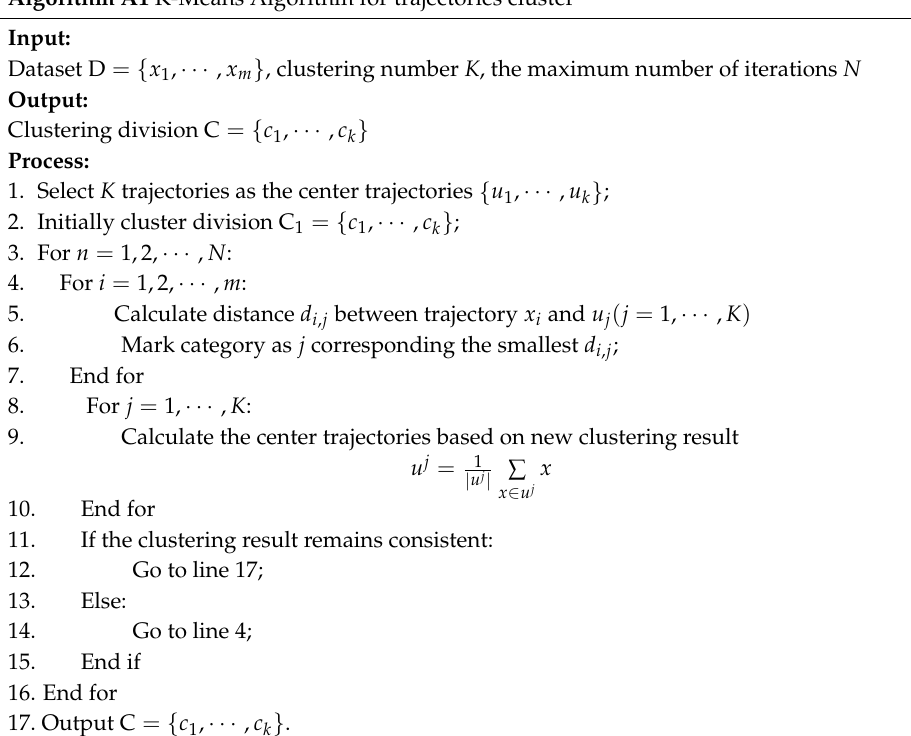
Algorithm A1 K-Means Algorithm for trajectories